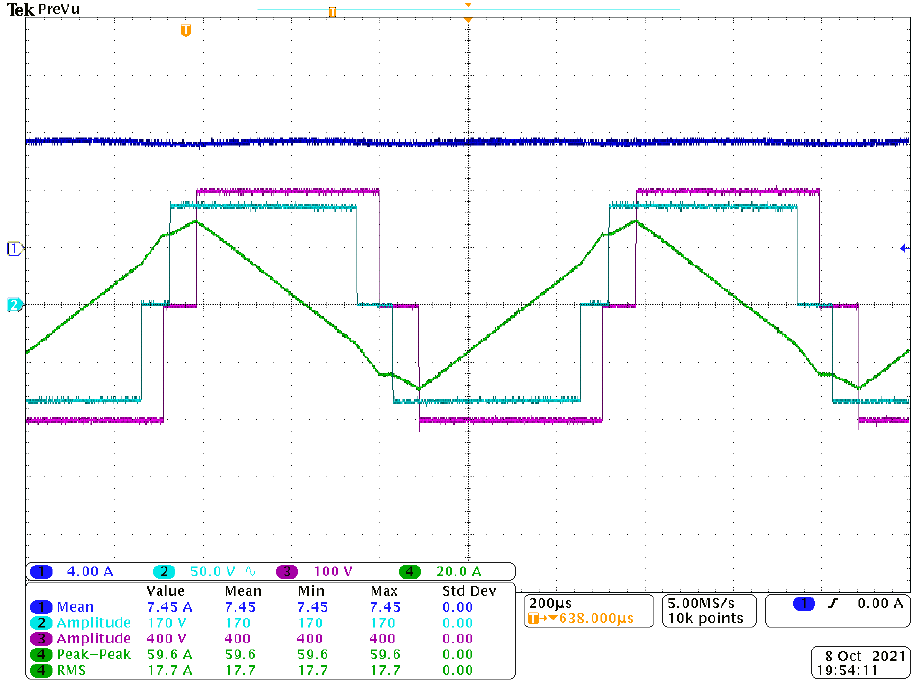
Figure 18. DAB operation under the TPS method at rated power.